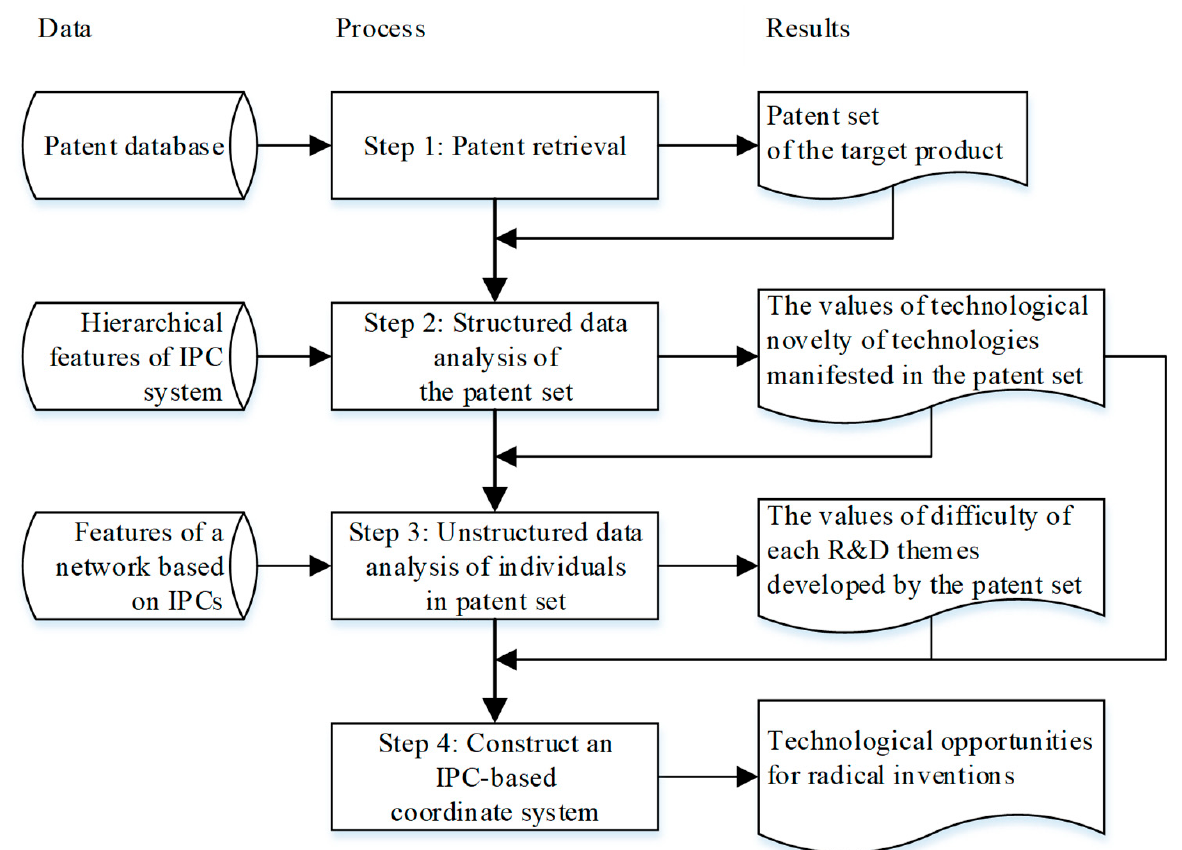
Figure 2. Framework for identifying technological opportunities of radical inventions.